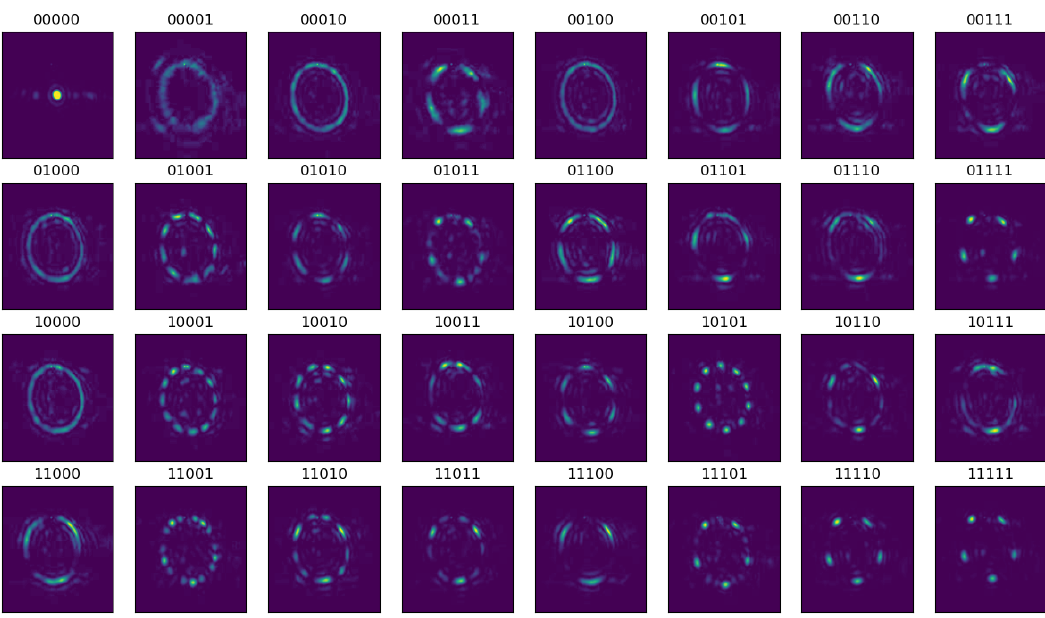
Figure 2. Example of OAM patterns from the free-space data